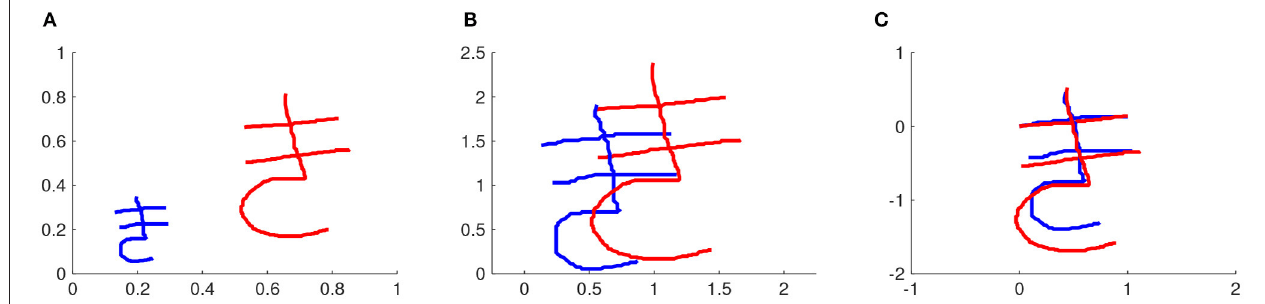
FIGURE 2 | Rescaling and repositioning different executions of a motor skill. In this example, the motor skill is writing a Japanese character. (A) Two demonstrations of a Japanese character. (B) After rescaling both characters. (C) After repositioning the characters such that the first position of the first stroke is ( x = 0, y = 0 ) . The first stroke is the reference stroke in this